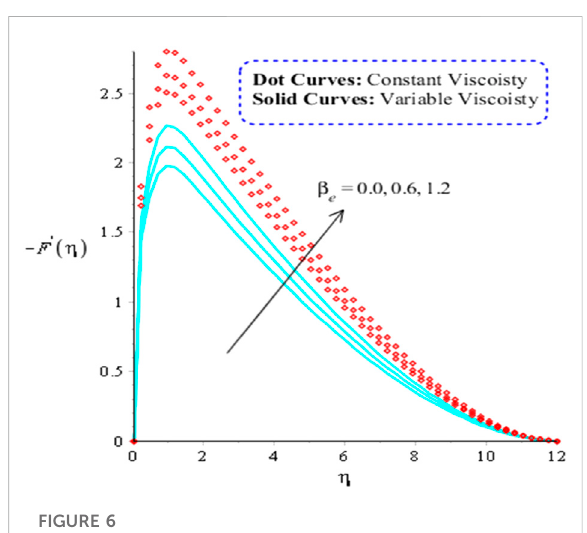
FIGURE 4 Variation in primary velocity fi eld versus β i .